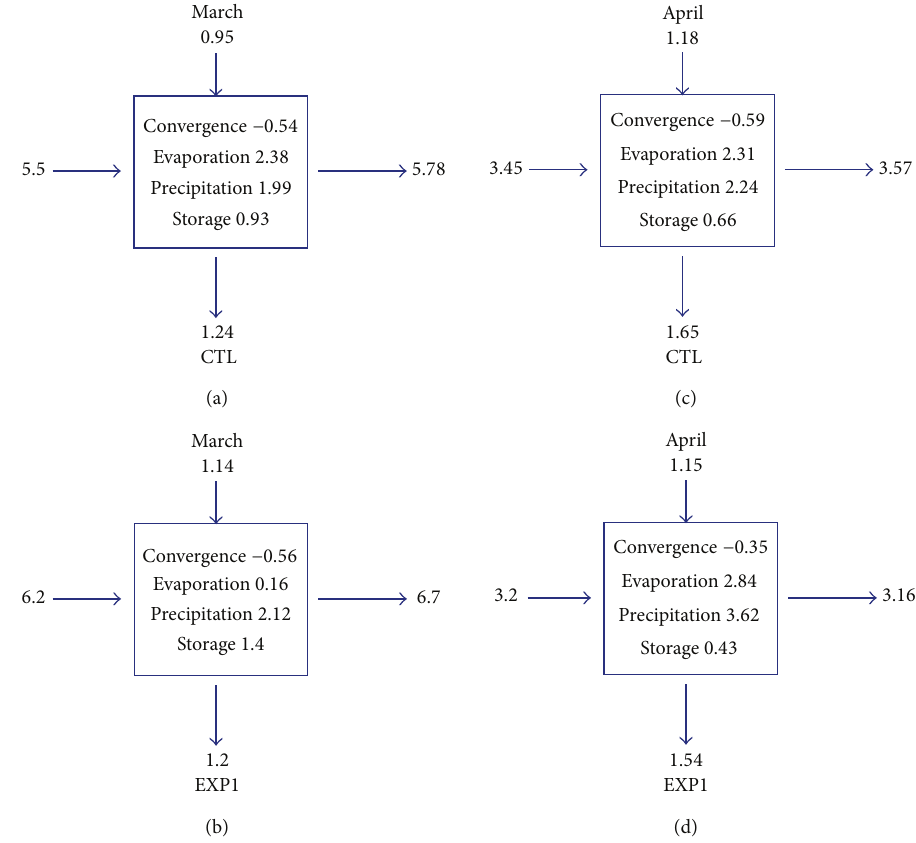
Figure 7: Atmospheric moisture budgets for box 2 shown in Figure 1 for March ((a)-(b)) and April ((c)-(d)) of CTL and EXP1, respectively. Units are in [ mm day −1 ]